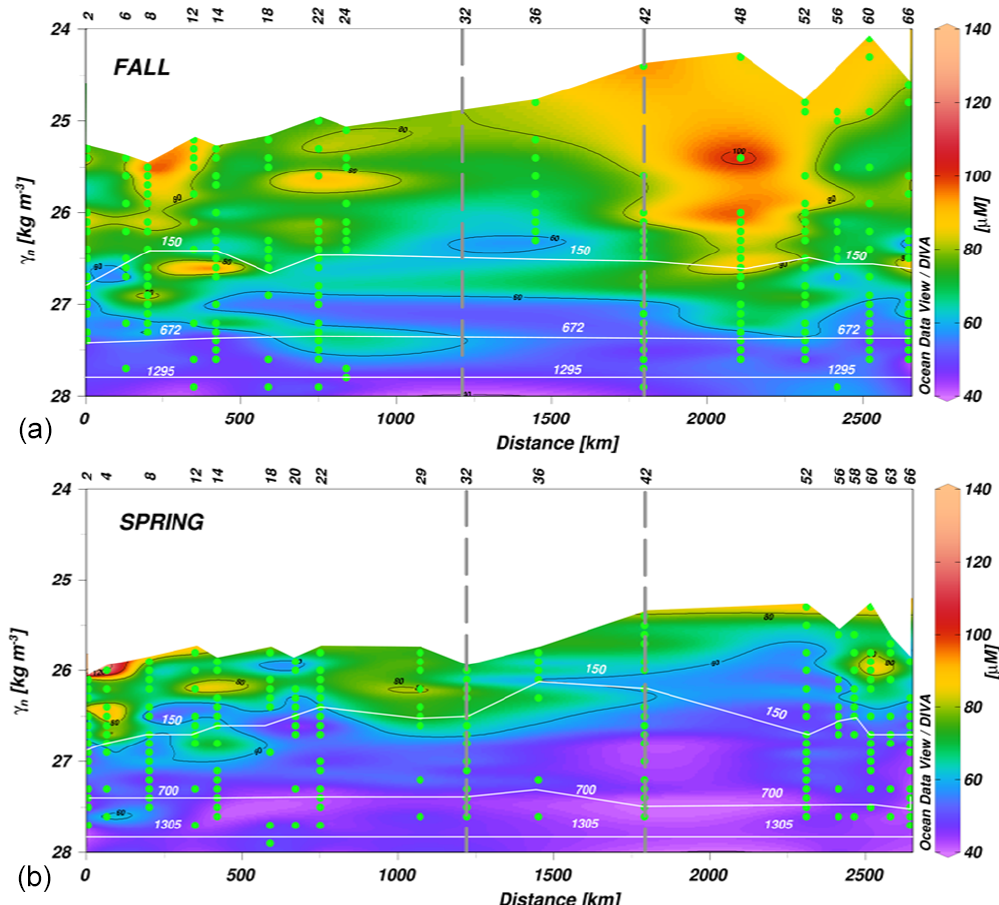
Figure 8. Sections of DOC concentration with respect to γ n during the fall (a) and spring (b) cruises with the white isolines as in the γ n sections in Figs. 4 and